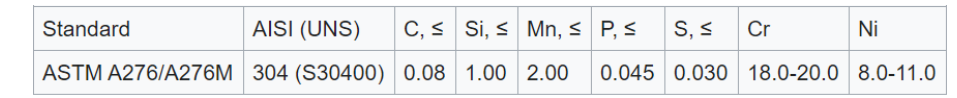
Figure 1: Schematic diagram representing (a) water contact angle on hydrophilic, hydrophobic, and superhydrophobic surfaces (4). (b) a proposed mechanism that could explain the droplet relaxation on samples textured with ripples and fixed on vertical support. (c) AFM scan (size: 10 x 10 μ m 2 ) of ripples replicated at 75% on polycarbonate. (d) A corresponding height profile of the AFM scan is presented in (c). Source for (b), (c), (d) (5).